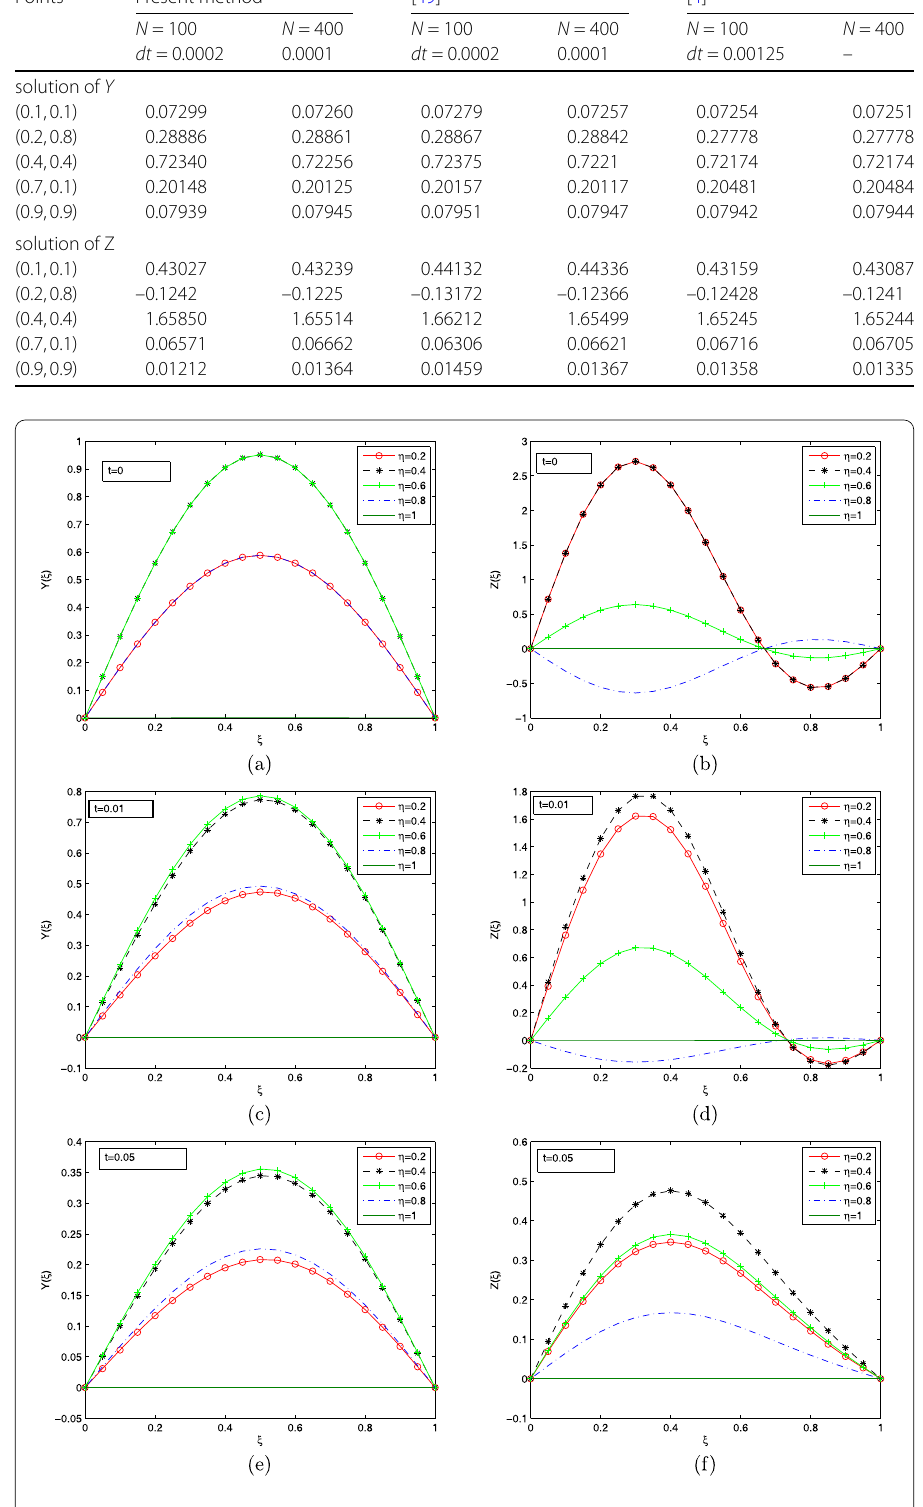
Figure 6 Solution profile of Example 8 at T = 0,0.01,0.05, N = 400, Re = 1, and dt =